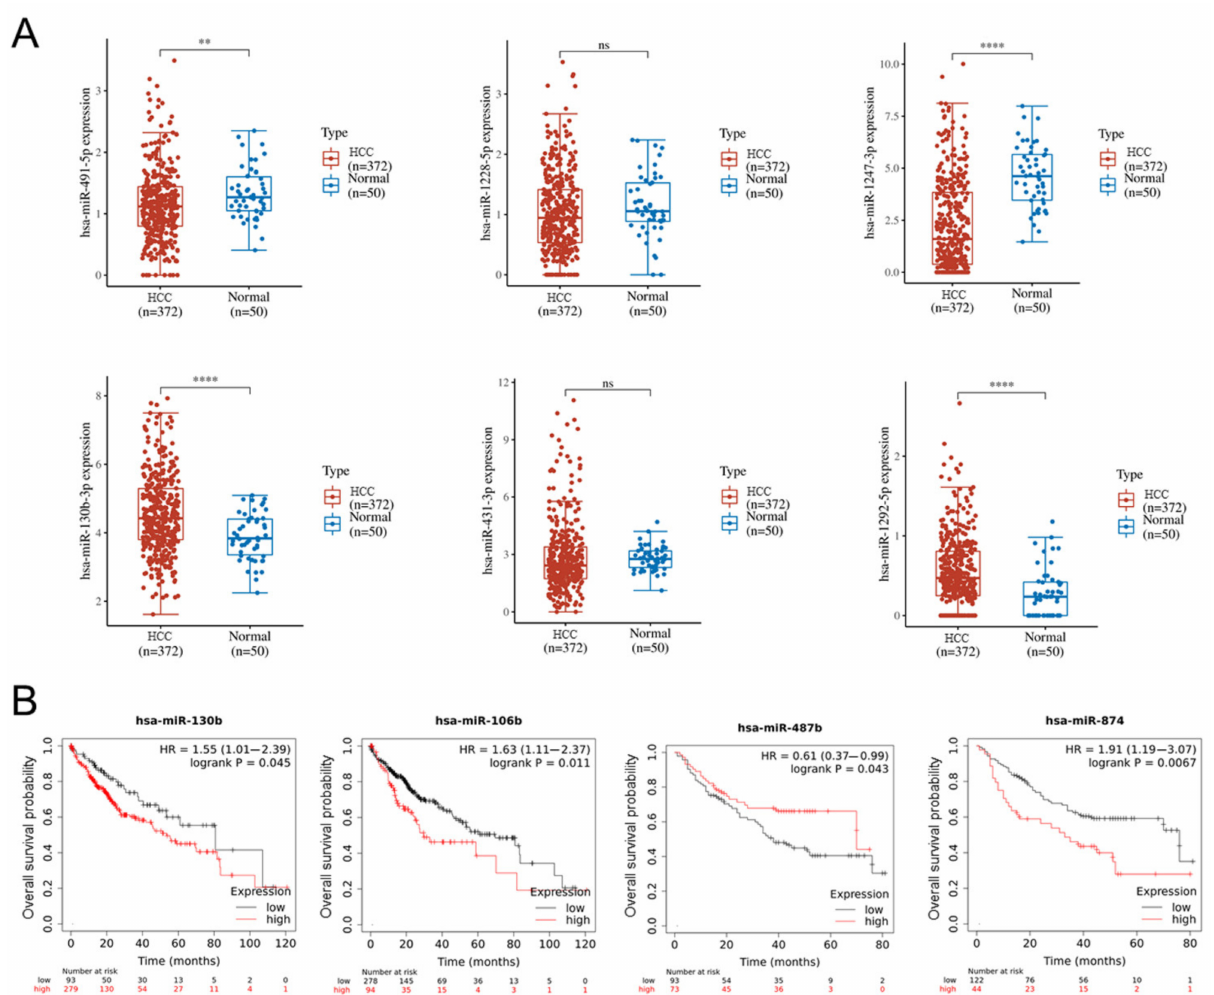
Figure 7. Altered microRNA expression and the relationship with overall survival in HCC. ( A ) Expression distribution of al- tered miRNAs after lenvatinib treatment in HCC and normal tissues based on TCGA database analysis, where different colors represent different groups. ** p < 0.01, **** p < 0.001, ns, no significant. ( B ) Lower levels of miR-130b, miR-106b, and miR-874, and higher levels of miR-487 are associated with longer overall survival of HCC patients (http://kmplot.com/analysis/, accessed on 5 October